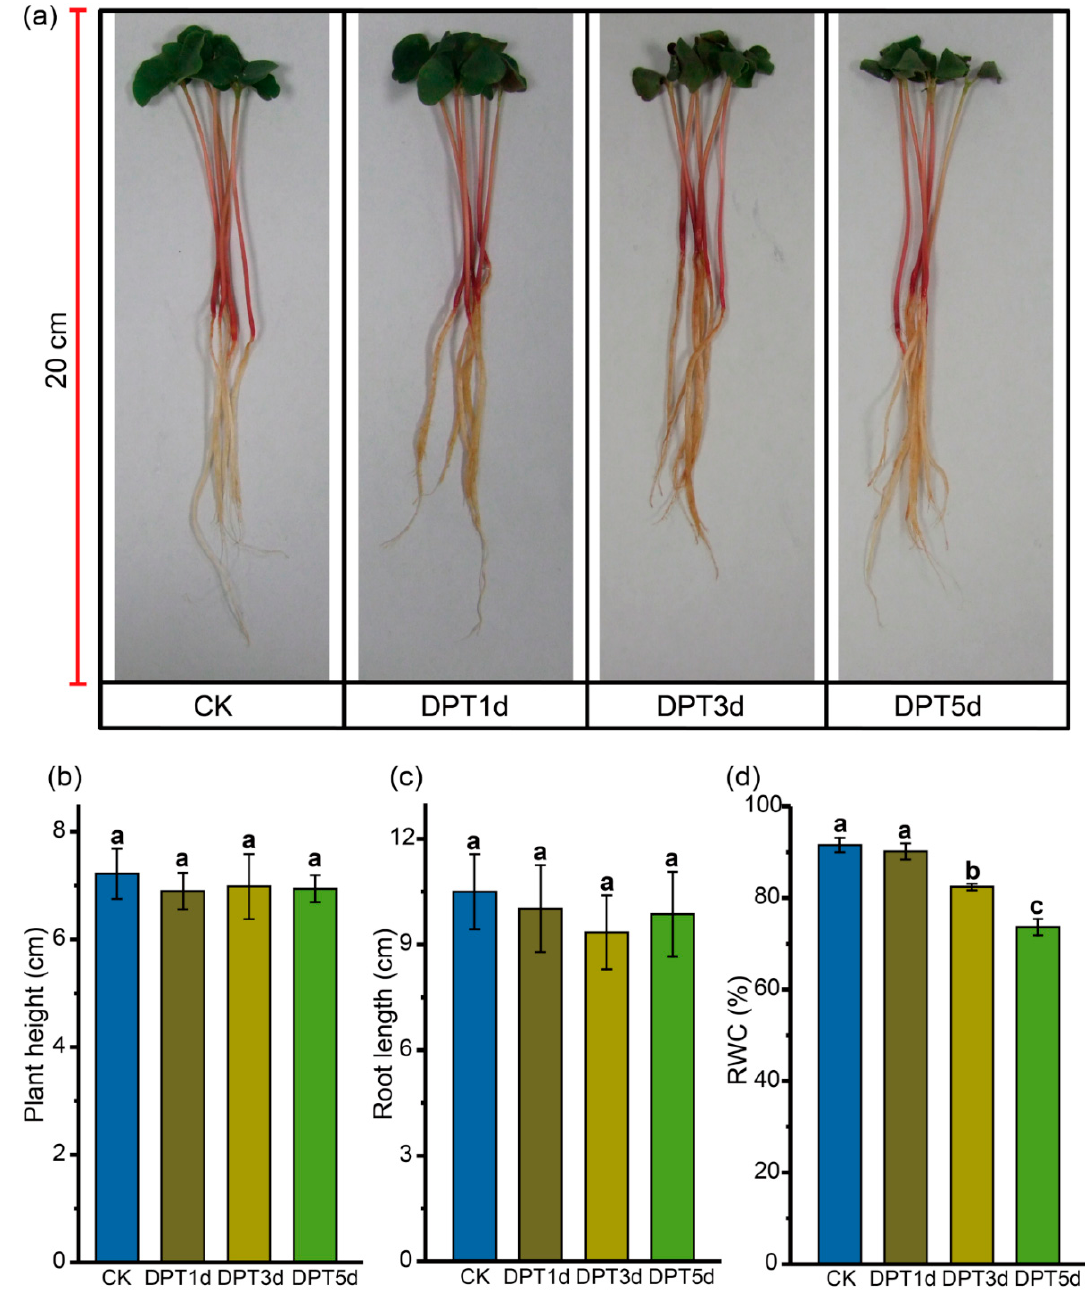
Figure 1. Changes in phenotype of common buckwheat seedlings under drought stress. ( a ) A photograph of common buckwheat seedlings after PEG treatments; CK, non-stressed control; DPT1d, DPT3d, and DPT5d, drought treatment with PEG solution for 1, 3, and 5 days, respectively; bar = 20 cm. The change of ( b ) plant height, ( c ) root length, and ( d ) relative water content of cotyledon during drought stress treatment. Bars represent means of three replicates ± SD (standard deviation). Different letters indicate means that are significantly different at the p < 0.05 level among different drought conditions.